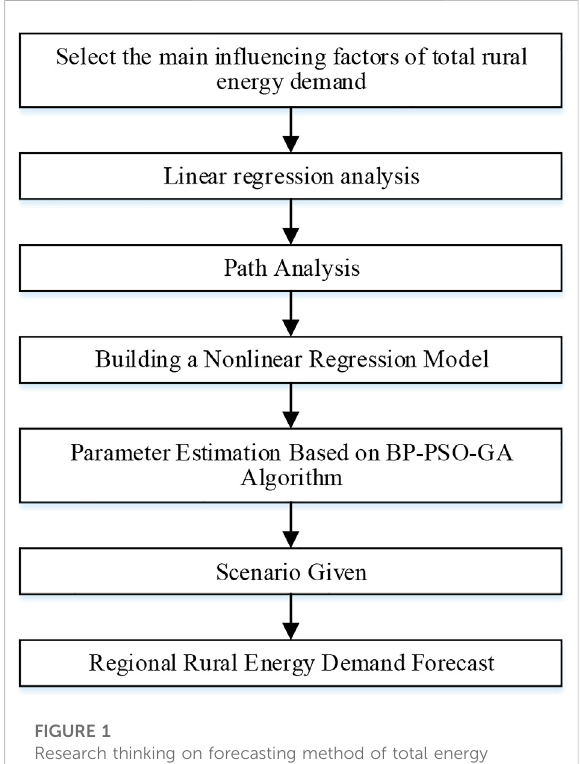
FIGURE 1 Research thinking on forecasting method of total energy demand in rural